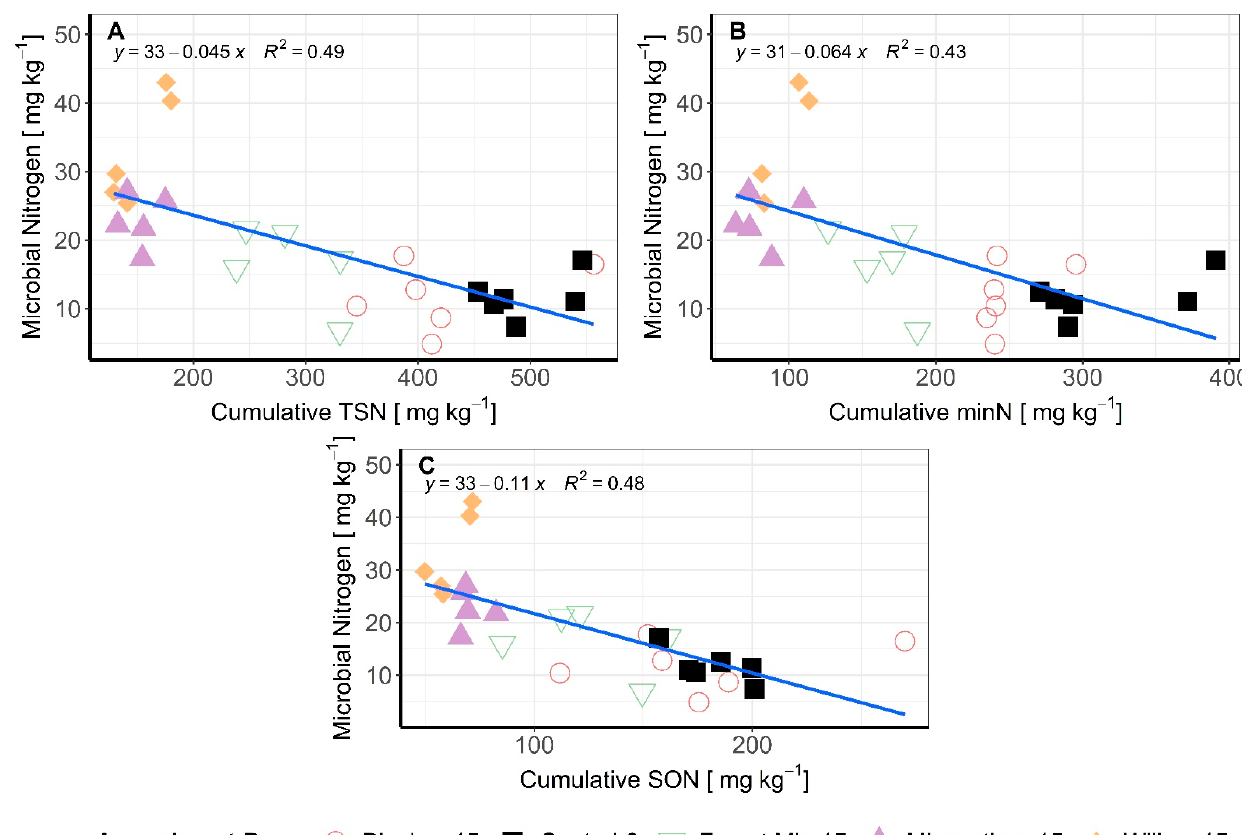
Figure 4. Cumulative measured TSN ( A ), minN ( B ), and calculated SON ( C ) after 26 weeks of incubation, in relation to microbial N content in the biomass at the end of the incubation for the two soil types. The data obtained on both soil types are combined. Amendments are represented by different colors and forms. The linear relationship is drawn, and the equation is presented at the top of the graph.